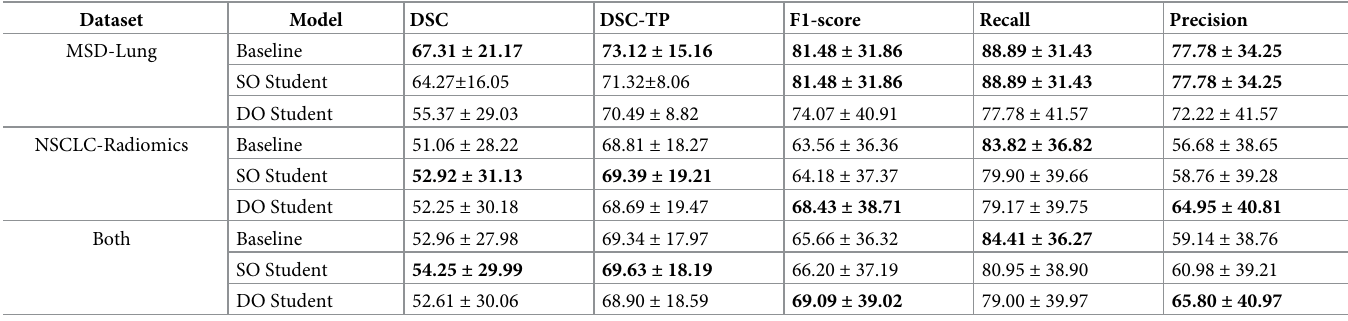
(without bounding boxes as input) teacher on both datasets in terms of DSC. The difference between the two models was less prominent measured on the MSD-Lung dataset than for the NSCLC-Radiomics dataset. For the final inference models, the DSC was highest on the MSD-Lung dataset, across all three models (see Table 3). The best performing student network overall was the SO Student, with highest DSC on the MSD-Lung dataset. There was negligible difference between the three Table 3. Student